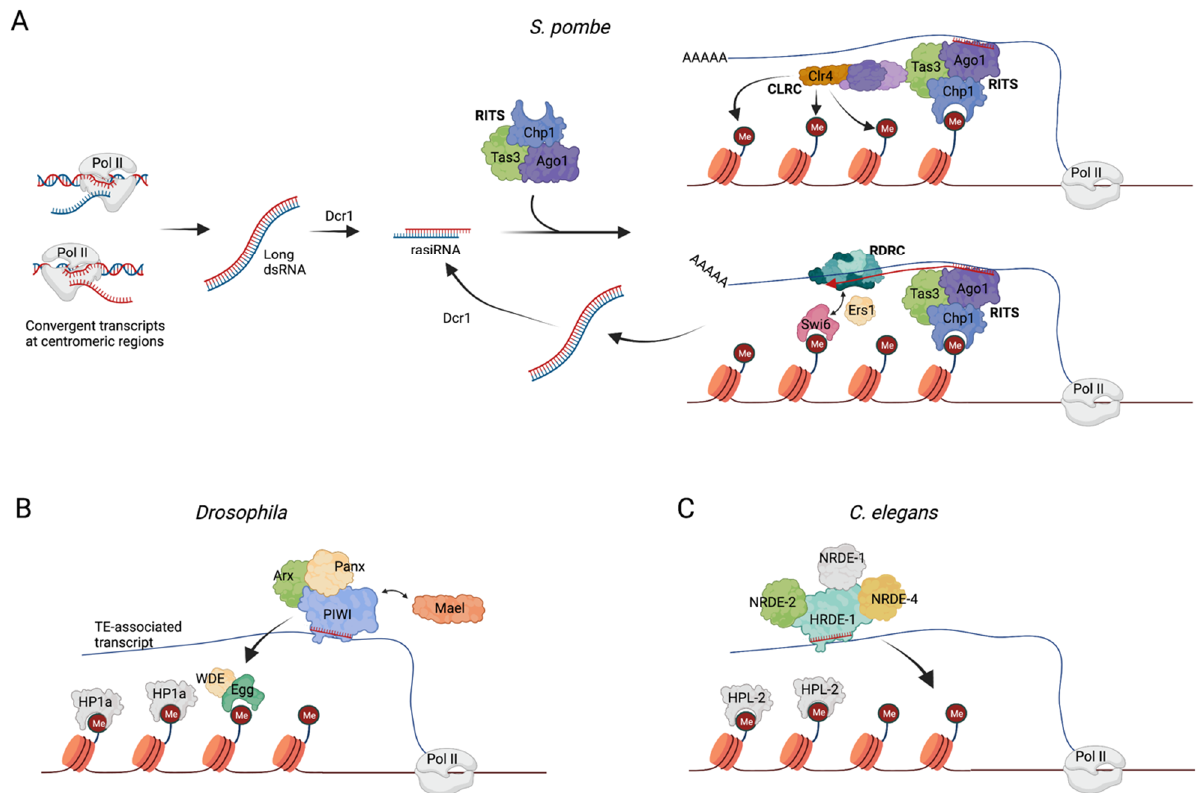
Figure 2. ( A ) The RITS complex in S. pombe . Convergent transcription at the targeted centromeric regions generates long double strand RNAs which are cleaved by Dicer1 (Dcr1) into small 25–30 nt dsRNAs, named repeat-associated siRNAs (rasiRNAs). One strand of the rasiRNA is loaded onto the RITS, and the resulting ribonucleoprotein complex is recruited on nascent transcripts spanning the targeted centromeric region. On the nascent transcript, the RITS can associate both with the CLRC complex to induce histone methylation, and with the RDRC complex to produce additional targeting rasiRNAs. RDRC recruitment is facilitated by Ers1, which acts as a bridge between the RDRC subunit Hrr1 and the chromodomain protein Swi6 [38]. ( B ) In Drosophila , Piwi–piRNA complexes bind TE-associated nascent transcripts, a process in which the proteins Arx and Panx take part. The histone methyltransferase, Egg, and the accessory protein, Wde, deposit H3K9me2/3 marks on transposon sequences, a process assisted by Mael. Next, HP1a binds to the targeted locus to maintain gene repression. ( C ) Mechanism of TGS in C. elegans operated by HRDE-1/WAGO-9 protein (details described in the main text).